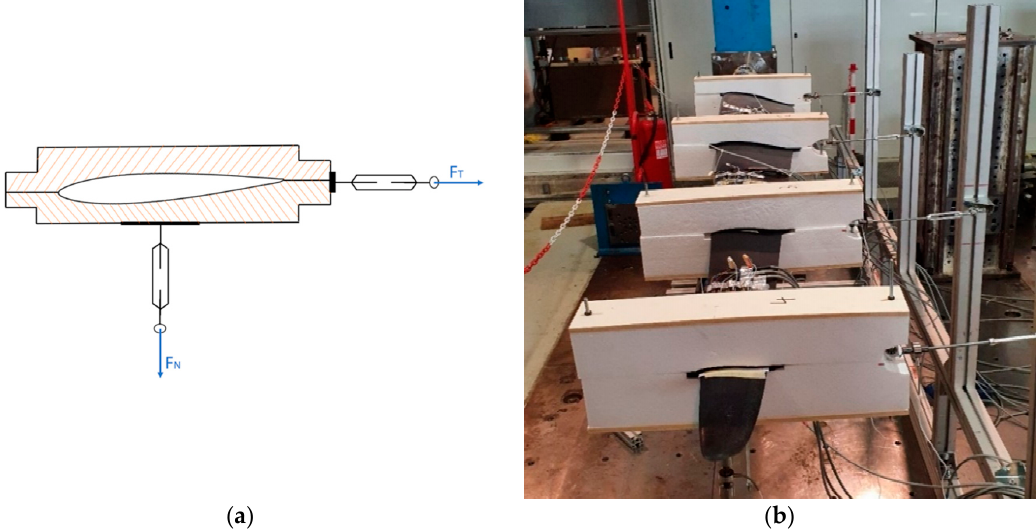
Figure 15. Schematic of the load-application mechanism ( a ). The blade static test bench ( b ).